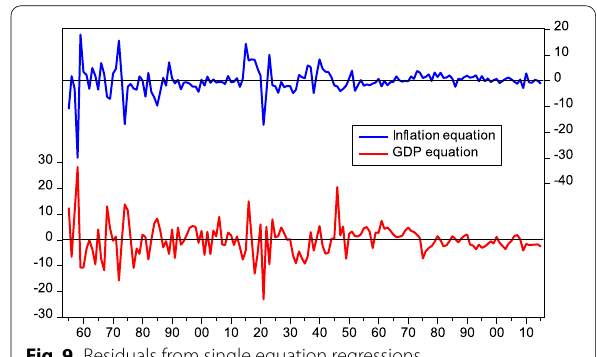
Fig. 9 Residuals from single equation